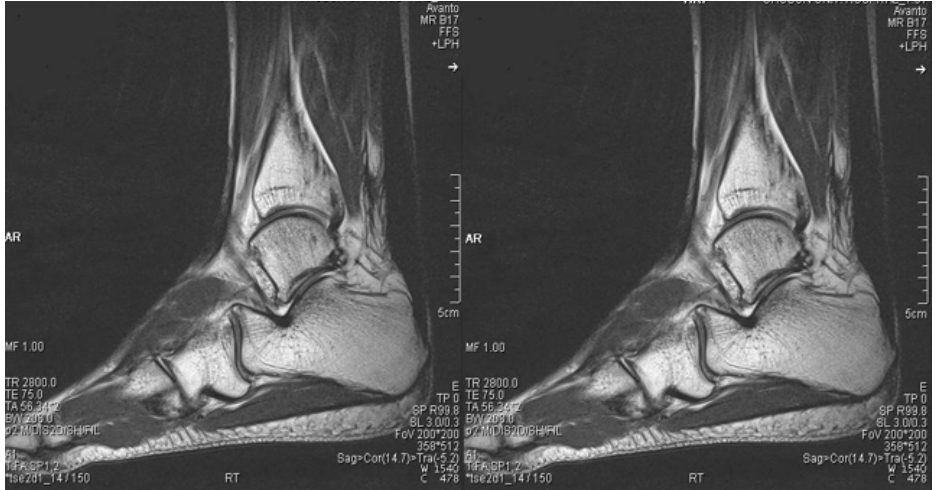
Figure 7. Postoperative (19 months after operation) sagi tt al magnetic resonance images of both an- kles showing good continuity of the Achilles tendons.